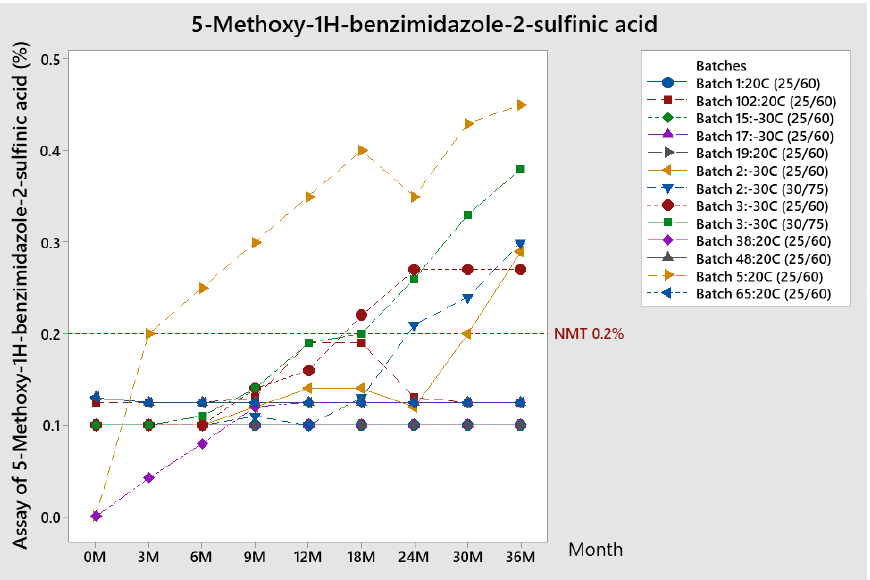
Figure 11. Trend of 5-Methoxy-1H-benzimidazole-2-sulfinic acid during stability study (conditions 25 °C/60% RH). 25 ◦ C/60%